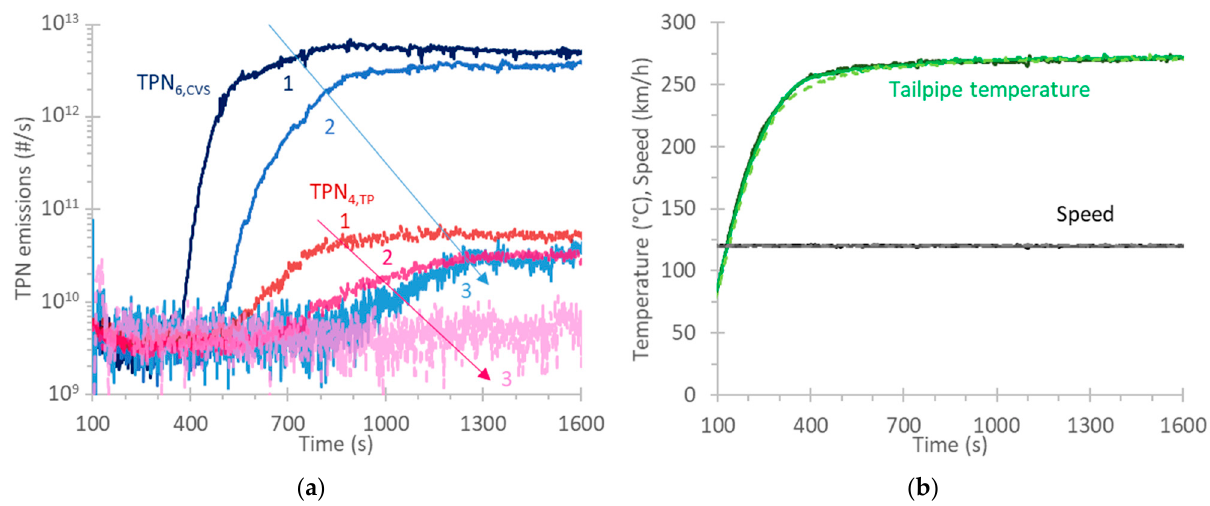
Figure 7. Three tests at 120 km/h at 330 km (1), 390 km (2), and 610 km (3): ( a ) Total particle number (TPN) emissions at the tailpipe (TP) or the dilution tunnel (CVS); ( b ) Speed and exhaust gas temperature at the tailpipe.